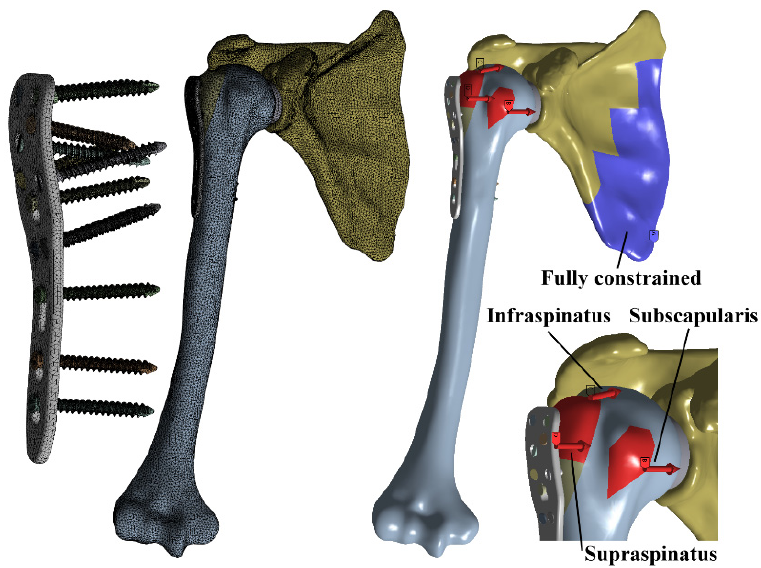
Figure 4. Finite element models under realistic rotator cuff muscle loading.